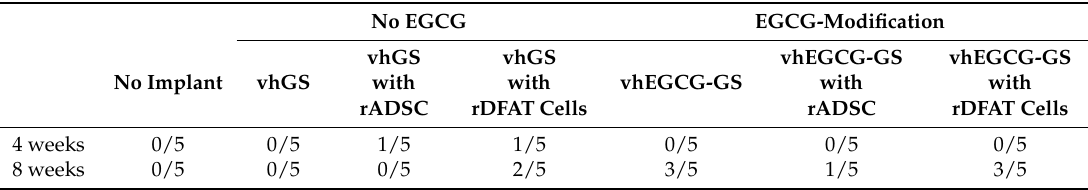
Figure 6. Representative histological and radiological images of the bone defects. ( A ) Low magnification of sections stained with hematoxylin-eosin (H-E). White squares: magnified area used in B-b and c. ( B-a ) Cross-section of µ CT images approximately coincided with H-E staining of vhEGCG-GS with rDFAT cells at 8 weeks. ( B-b , c ) High-magnification images of H-E staining of vhEGCG-GS with rDFAT cells at 8 weeks. ( C ) Low- and high-magnification images of toluidine blue staining of vhEGCG-GS with rDFAT cells at 8 weeks. White squares: magnified area. Table 1. Summary of cartilage formation.